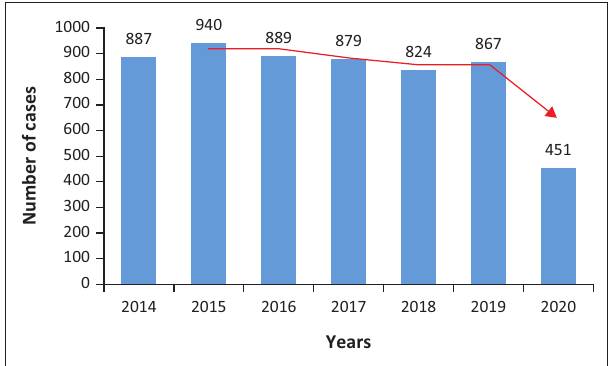
FIGURE 1: Annual distribution of sexual assault cases reported between 01 January 2014 and 31 December 2020 at Sinawe Thuthuzela Care Centre,